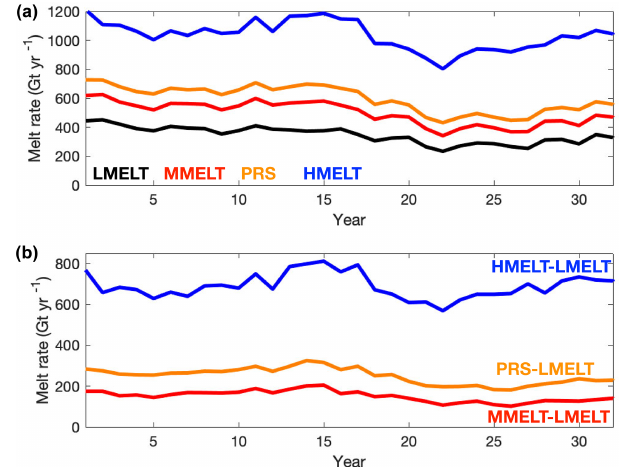
Figure 3. Time series of area-integrated annual mean melt rates for (a) Amundsen and Bellingshausen seas for LMELT, MMELT, PRS, and HMELT. (b) Difference in integrated annual mean melt rates for AS and BS ice shelves between HMELT and LMELT (blue), PRS and LMELT (orange), and MMELT and LMELT